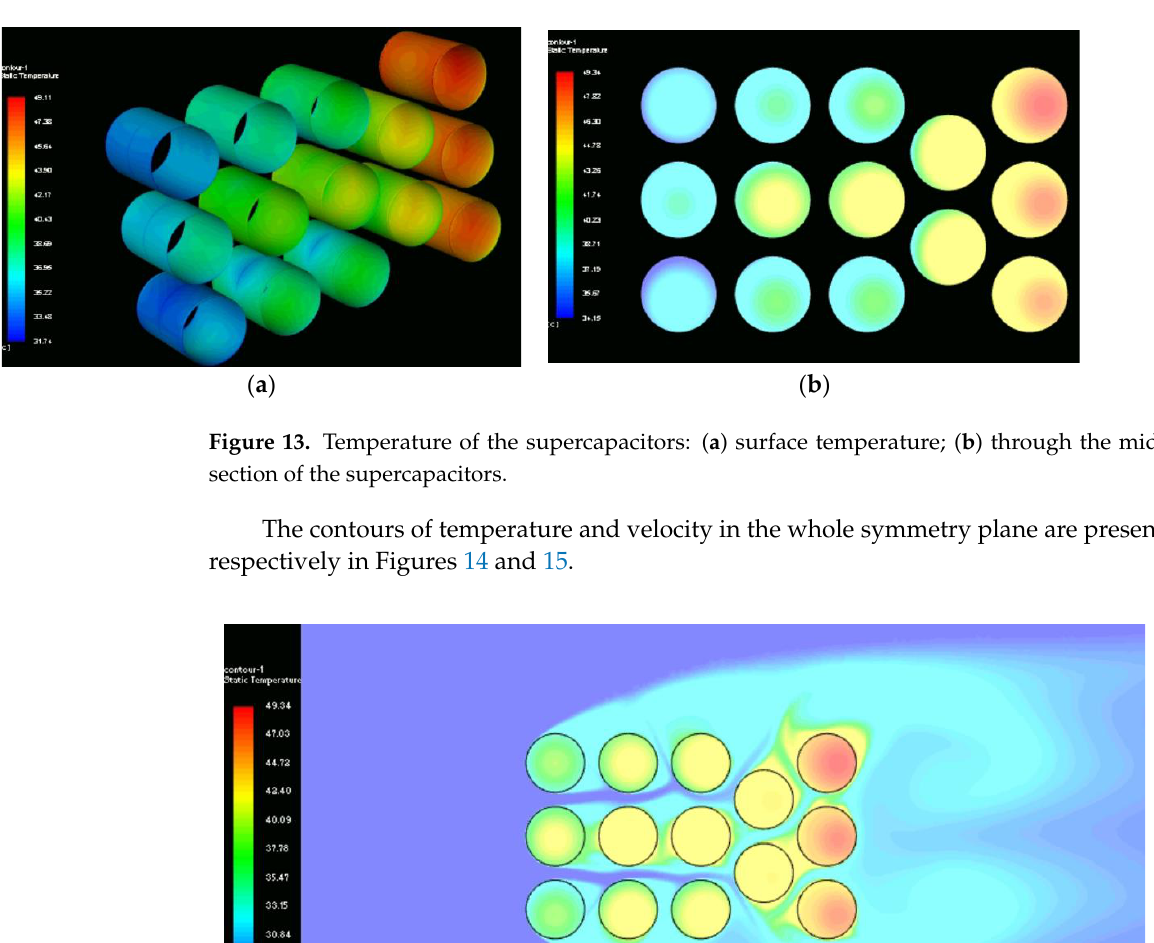
Figure 15. Velocity contours in the middle longitudinal plane. It can be seen on Figure 15 that the velocity field changes between the third and the fourth row. For the SCs aligned distribution, the main flow is tangential on the SCs lateral surface. After the modification of the arrangement distribution, which occurs between the thirds and fourth row, a significant flow is oriented perpendicular to the center of the SCs